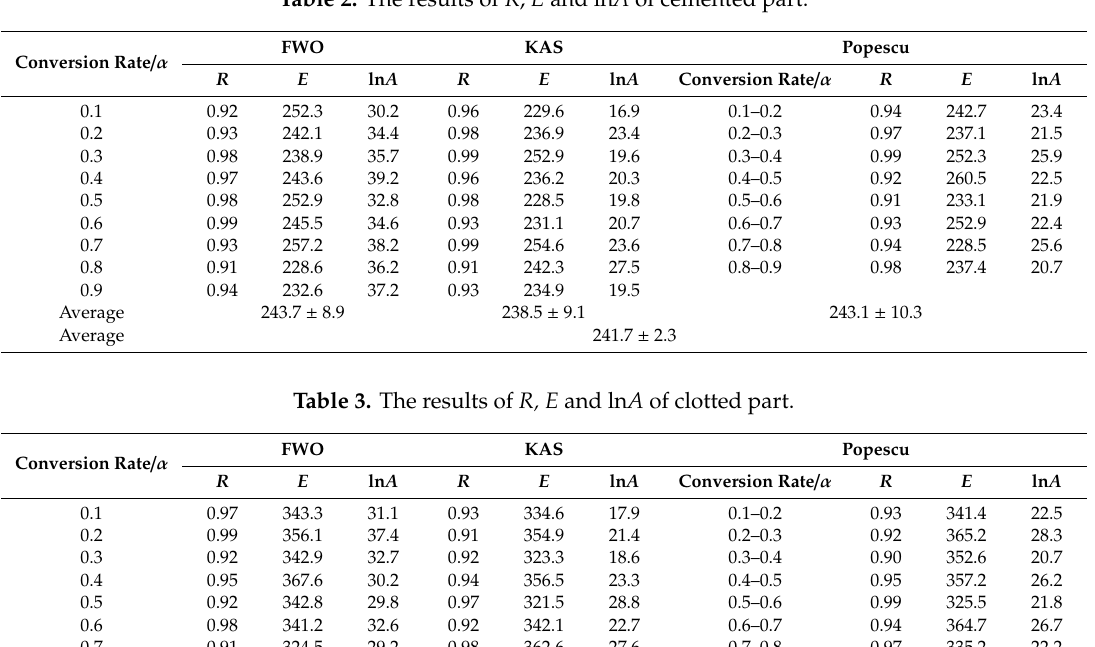
Table 2. The results of R , E and ln A of cemented part.